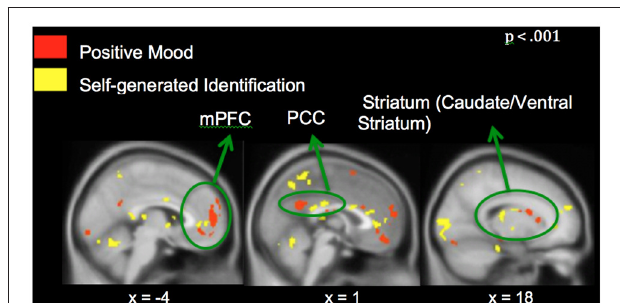
FIGURE 5 | Whole-brain conjunction analyses illustrating positive mood effect (in red) and self-generated identification effect (in yellow) in medial prefrontal cortex (mPFC), posterior cingulate cortex (PCC) and